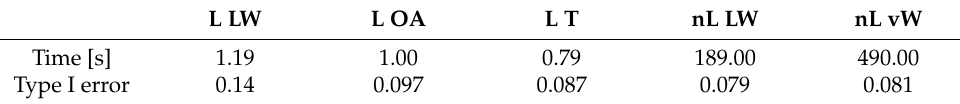
Table 1. Evaluation of the computational time and type I error for one simulated dataset with N = 25 P = 250 and a type (iii) covariance matrix for the different classes of eigenvalue-shrinkage methods, see Section 4. One-hundred test observations (with the same distribution as the set of references) are used to compute the type I error. A significance level of 0.05 was used. L